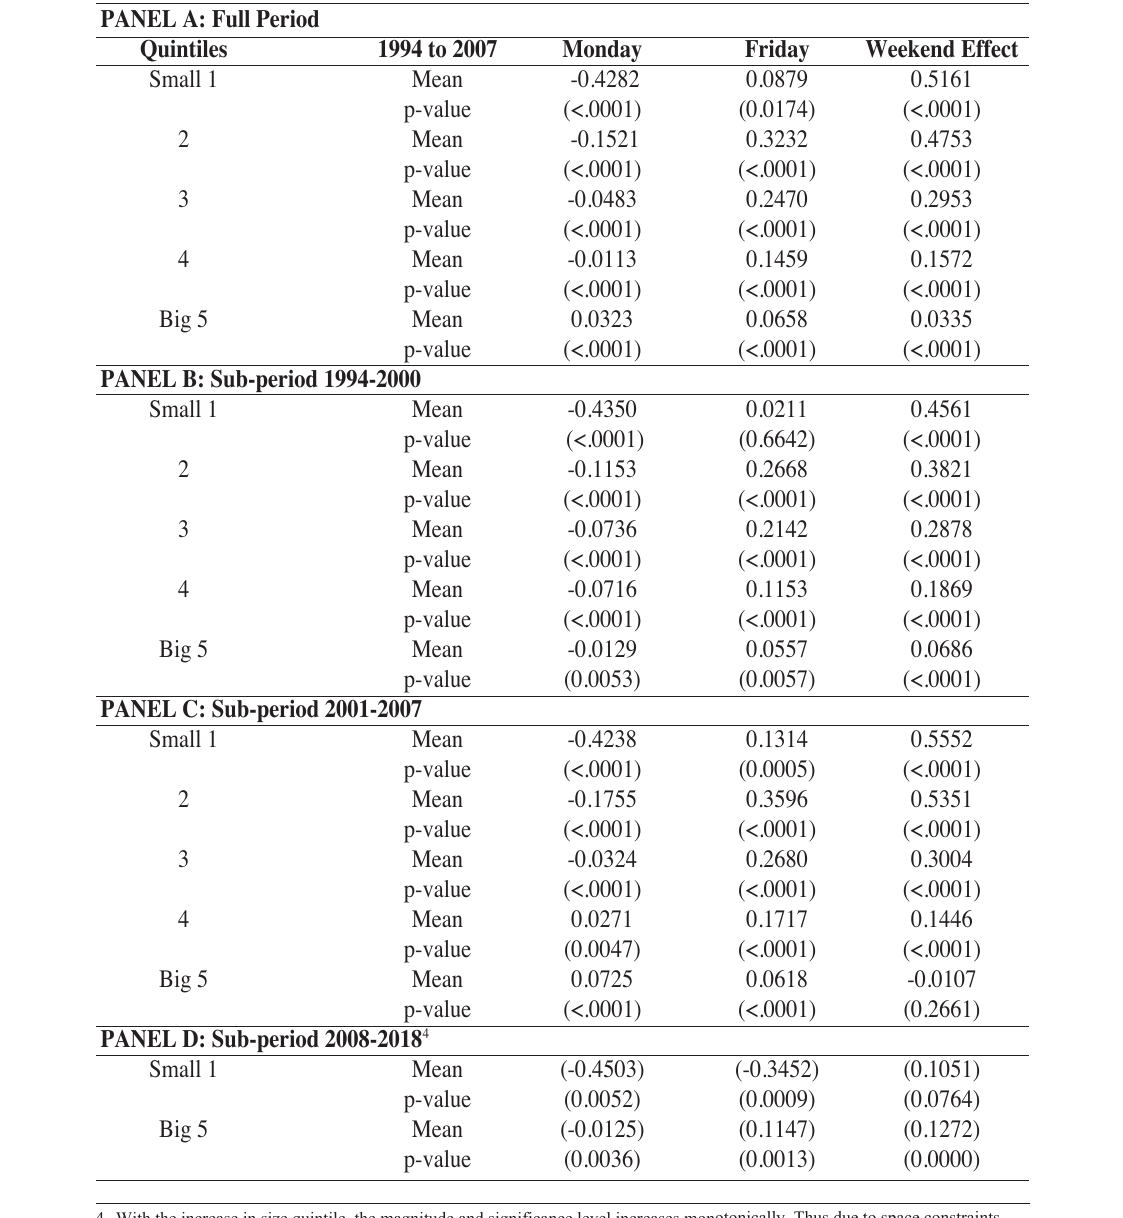
Table 4: Firm Size